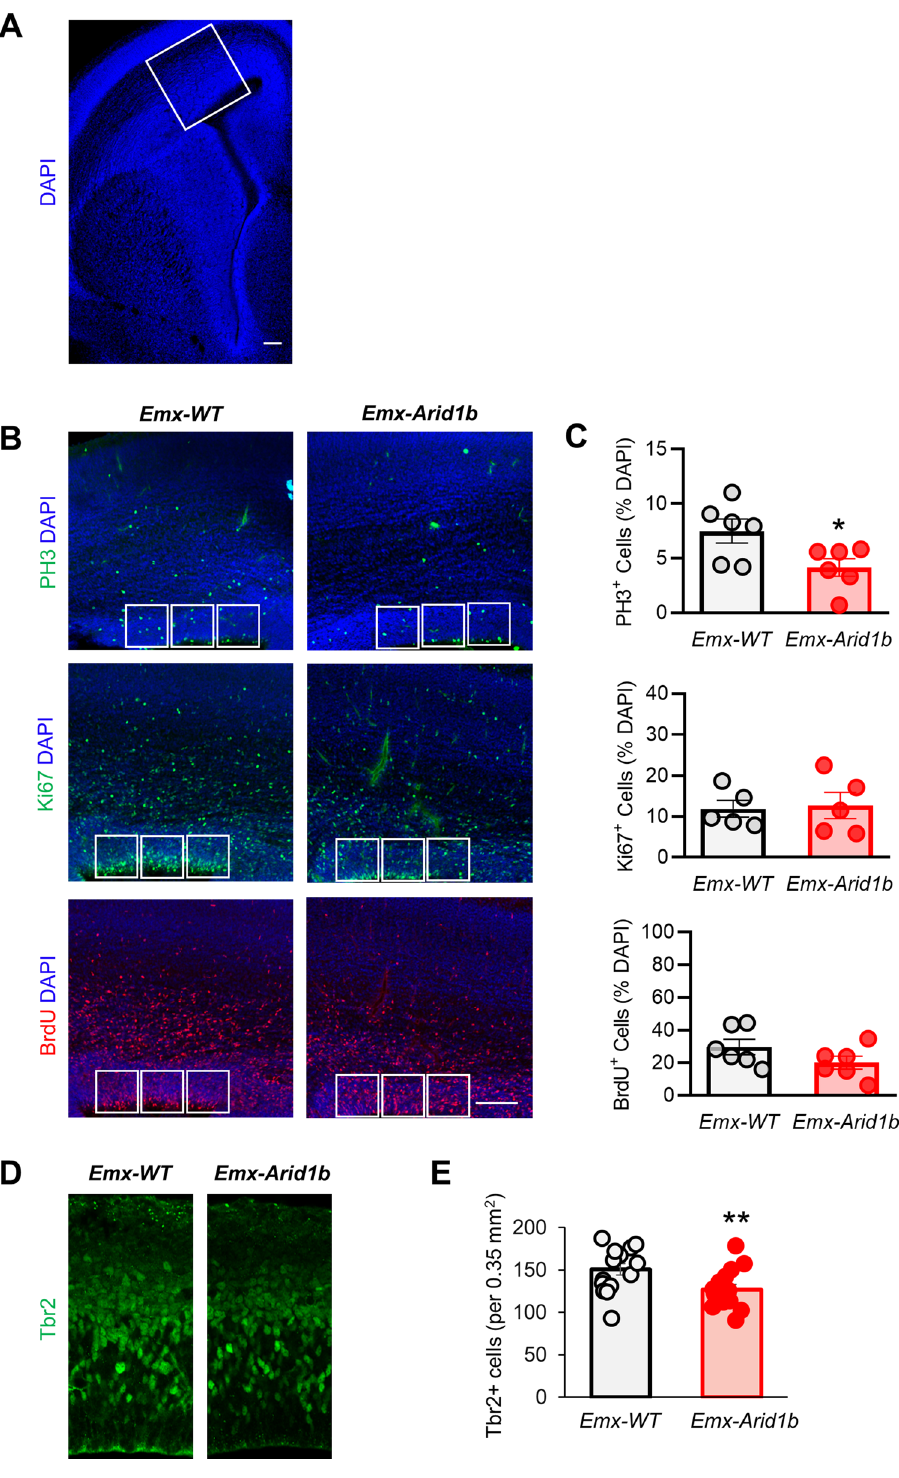
Figure 1. Arid1b deletion decreases cortical progenitor proliferation. ( A ) Representative low magnification image demonstrating the cortical brain sections examined in ( B ). ( B ) Immunostaining of coronal cerebral cortical sections from E14.5–15.5 control and Arid1b LoxP/LoxP ;Emx1-Cre ( Emx-Arid1b ) brains with anti-phosphorylated Histone H3 (PH3), anti-Ki67 or anti-BrdU antibodies with DAPI co-stain. Representative images from both six control and Emx-Arid1b brains for PH3 and BrdU and five from each genotype for Ki67. Scale bars: 50 μm. White boxes (2.5 mm 2 ) indicate regions of interest in the VZ of the developing cerebral cortex that were quantified and averaged for each animal. ( C ) Quantifications of the percentage of DAPI-positive cells co-labeled with the indicated antibody for panels in ( B ), respectively. N = 6 mice for each condition for PH3 and BrdU and N = 5 for each condition for Ki67. Sections were co-immunostained for DAPI, BrdU and PH3/Ki67. ( D ) Cortical sections of control and mutant samples were immunostained with an anti-Tbr2 antibody. ( E ) Quantification of ( D ). N = 15 mice for each condition. Statistical significance was determined by two-tailed Student’s t test. Error bars show standard error of the mean (SEM). * p < 0.05, ** p <